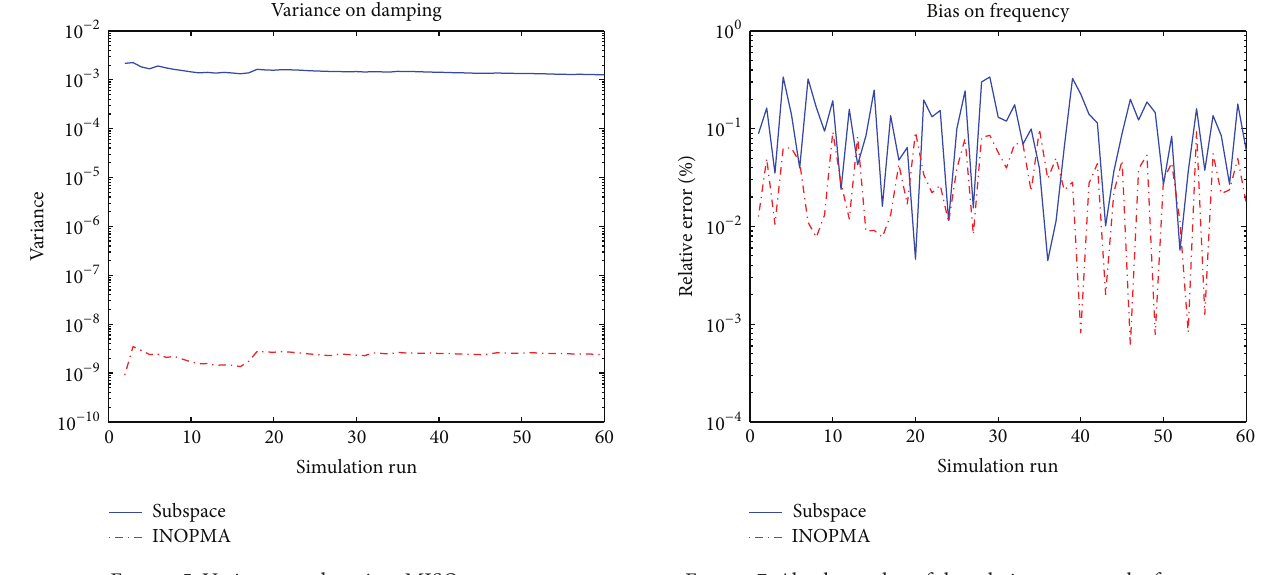
Figure 5: Variance on damping: MISO system.